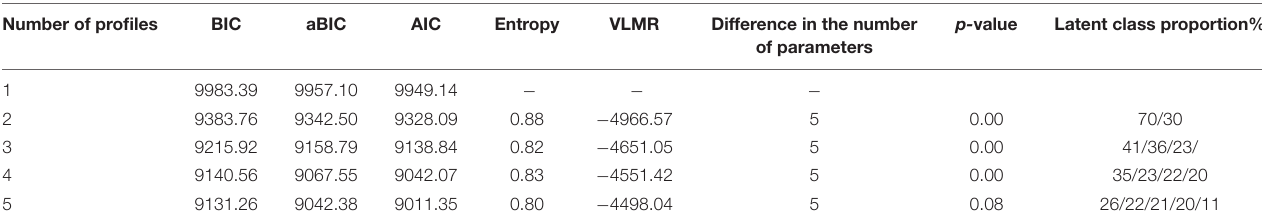
TABLE 2 | Fit indices for the compared latent profiles. Number of